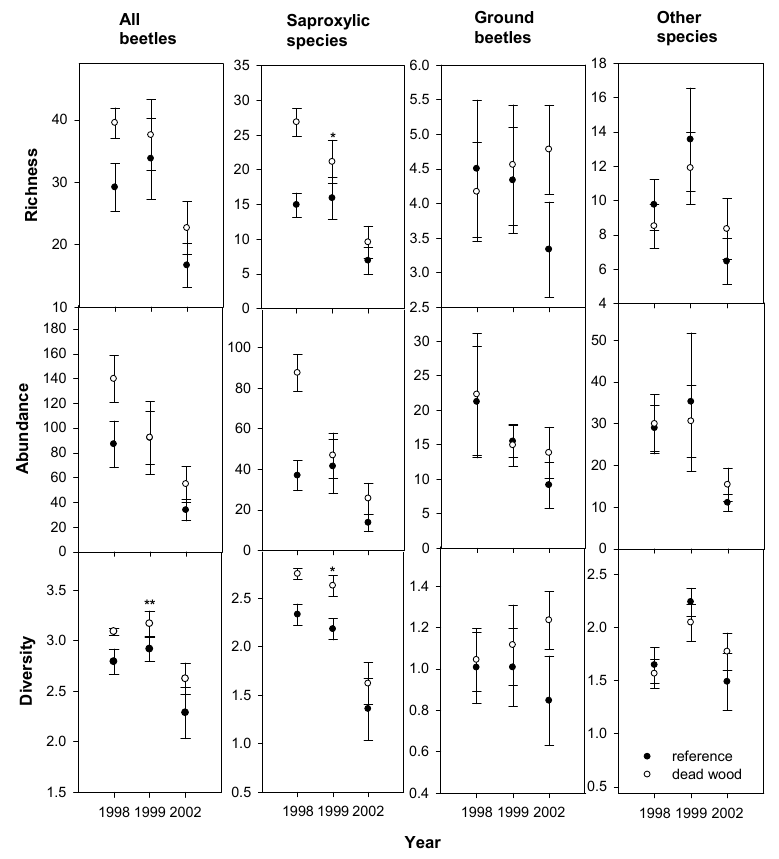
Figure 1. Mean ± SE ( n = 12 for 1998 and 9 for 1999 and 2002) species richness, abundance, and Shannon’s diversity of beetles collected in plots in which dead wood was added or not (open and closed circles, respectively). Results for all beetle species combined are given in the left-most column followed by saproxylic species only, ground beetles only, and other species. Asterisks denote significant p -values: * < 0.05, ** < 0.01, *** < 0.001 based on analyses of variance.